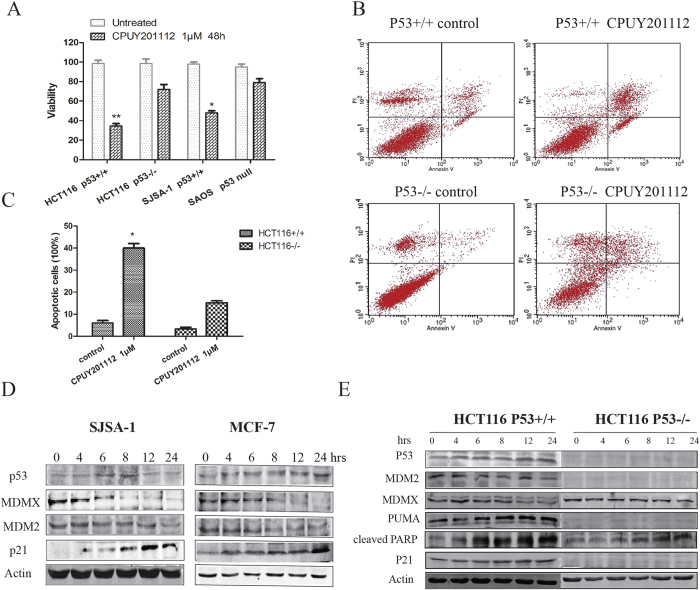
CPUY201112 enhances wt-p53 signaling and kills cancer cells in a wt-p53-dependent manner.(A) Cell viability assay. Cell lines with different p53 states were treated with CPUY201112 for 48 h, and the viability of cells was detected by the MTT method. (B) CPUY201112 shows better cytotoxic cell killing in the wt-p53 tumor cells HCT116 p53+/+ versus HCT116 p53 −/−, as demonstrated by Annexin-V and PI staining and measured by FACS. (C) The quantification of cell apoptosis induced by 2 μM CPUY201112 in HCT116 p53+/+ and HCT116 p53−/− after treatment for 24 h. (D) CPUY201112 increases p53 and p21 but decreases MDM2 and MDMX protein levels. MCF-7 and SJSA-1 human cancer cells were treated with 2 μM of CPUY201112 for the indicated time periods. The levels of p53, MDMX, MDM2 and P21 proteins were analyzed by immunoblots. Actin was used as a loading control. The blots are cropped and the gel were run under the same condition. (E) In response to CPUY201112, p53−/− tumor cells show much lower PARP cleavage and lack p21 and PUMA induction compared with isogenic p53+/+ cells. The cell pairs were treated with 2 μM CPUY201112 or DMSO. The levels of the indicated proteins were analyzed by immunoblotting.